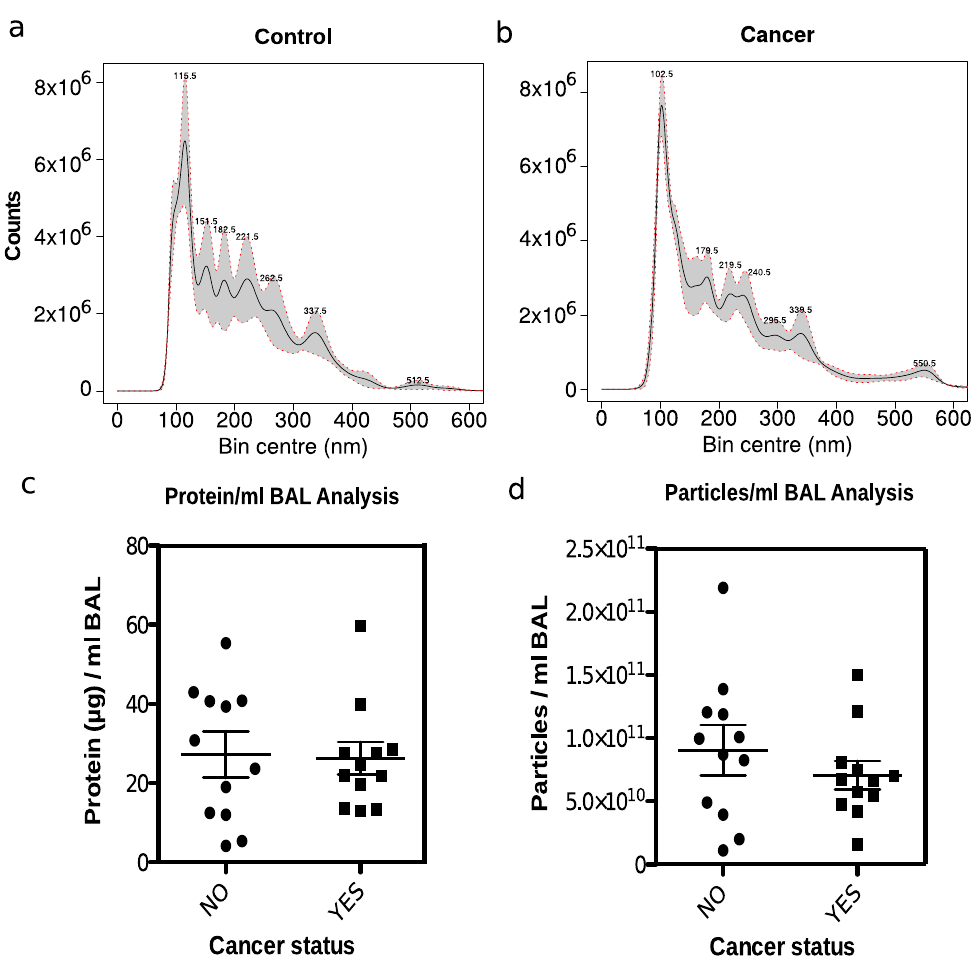
Figure 2. Nanoparticle tracking analysis of sEV samples: ( a ) particle counts versus particle size in nm for a control sample; ( b ) and a lung cancer sample; ( c ) protein concentration in sEVs versus cancer status; ( d ) particle concentration versus cancer status.